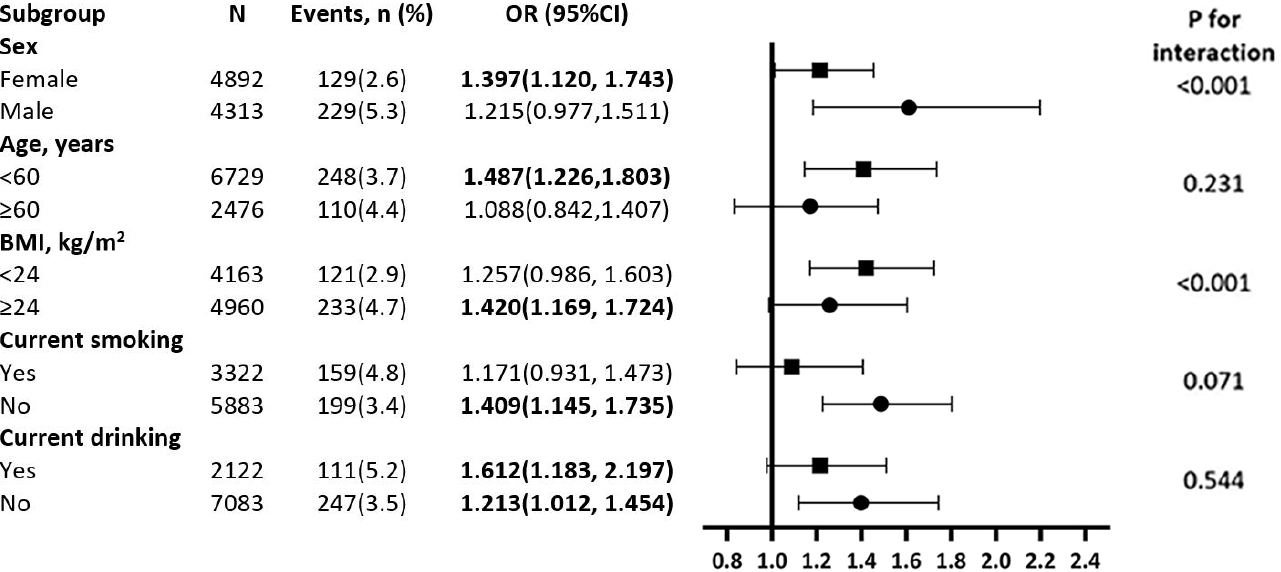
Figure 3. Subgroup analysis of the association between WWI and incidence of diabetes among rural Chinese. Each subgroup analysis is adjusted if not stratified for age, heart rate, current smoking, current drinking, high density lipoprotein, low density lipoprotein, body mass index, systolic blood pressure, diastolic blood pressure, sleep duration, educational status, ethnicity, annual income (CNY/year), and physical